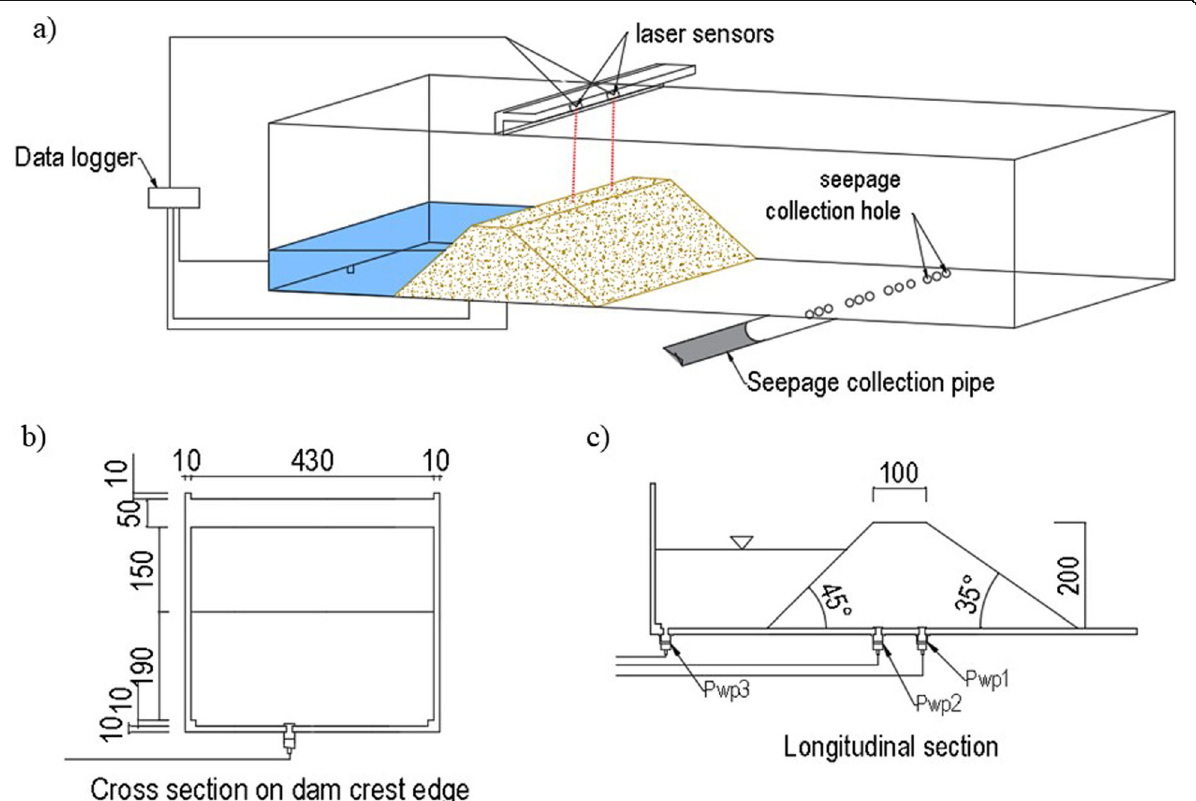
Fig. 2 Experimental setup of flume tank. a 3D view b cross-section and c longitudinal